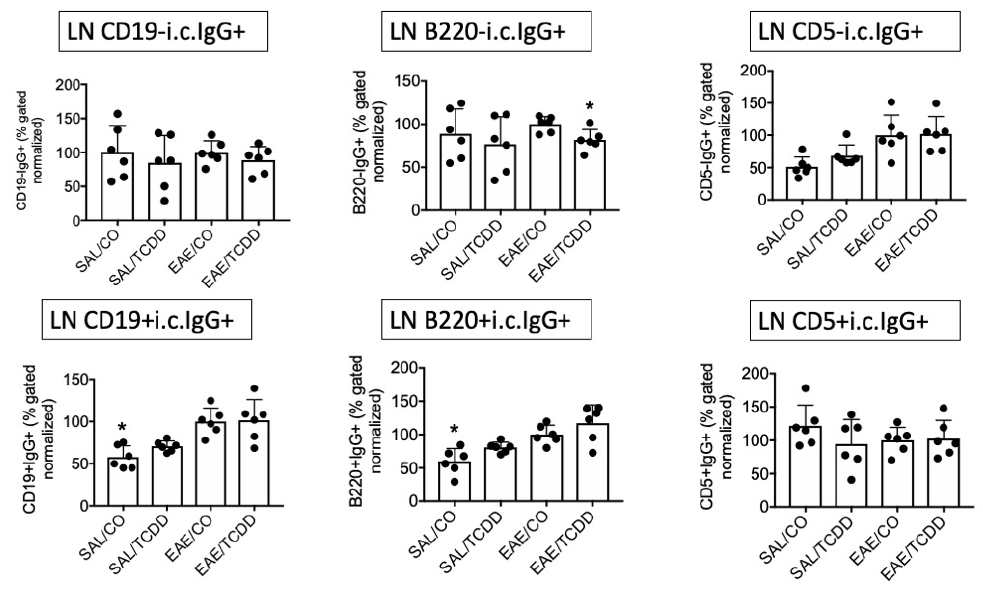
Figure 2. TCDD effect on i.c. IgG in LN in EAE. Samples were obtained as in Figure 1, but from LN. * p < 0.05 as compared to EAE/CO using Friedman’s ANOVA and Dunn’s post hoc test. i.c., intracellular; LN, lymph nodes.